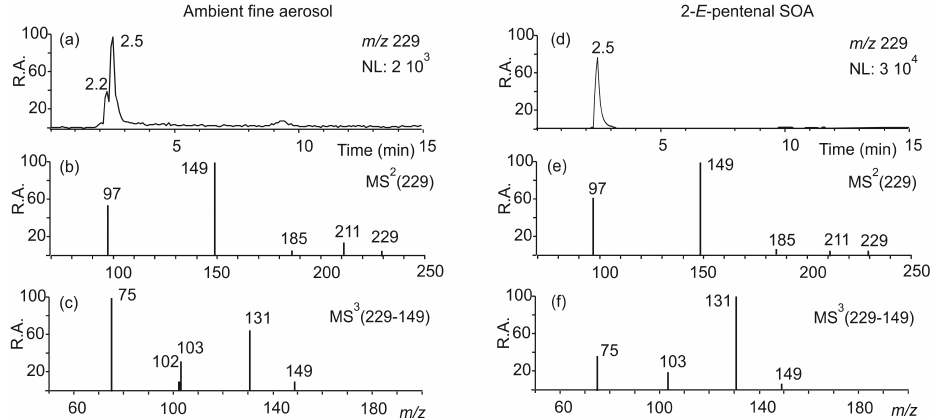
Figure 2. Selected LC–MS chromatographic data ( m/z 229 EICs) for (a) ambient fine aerosol and (d) SOA generated from 2- E -pentenal in the presence of acidic seed aerosol, as well as selected MS data (MS 2 or MS 3 product ion spectra) for the peak eluting at 2.5min in (b, c) ambient aerosol and (e, f) 2- E -pentenal